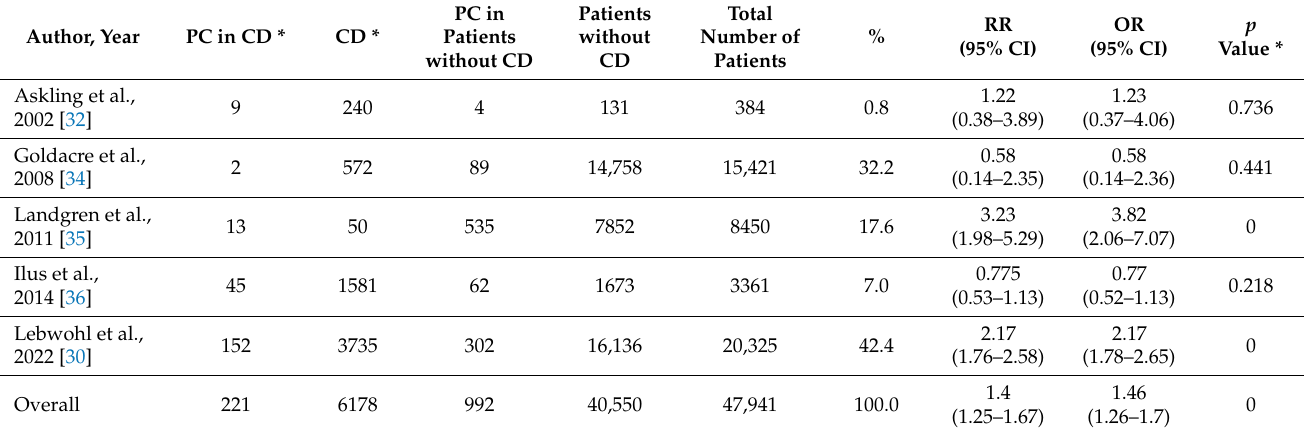
Table 3. Analysis of the association between celiac disease and pancreatic cancer